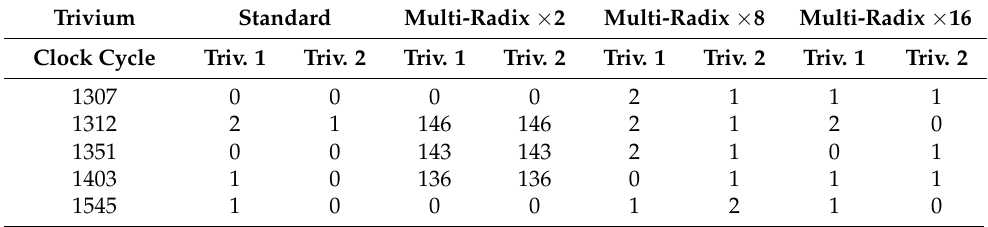
Table 5. Number of faults injected into each pair of Trivium cipher versions in different clock